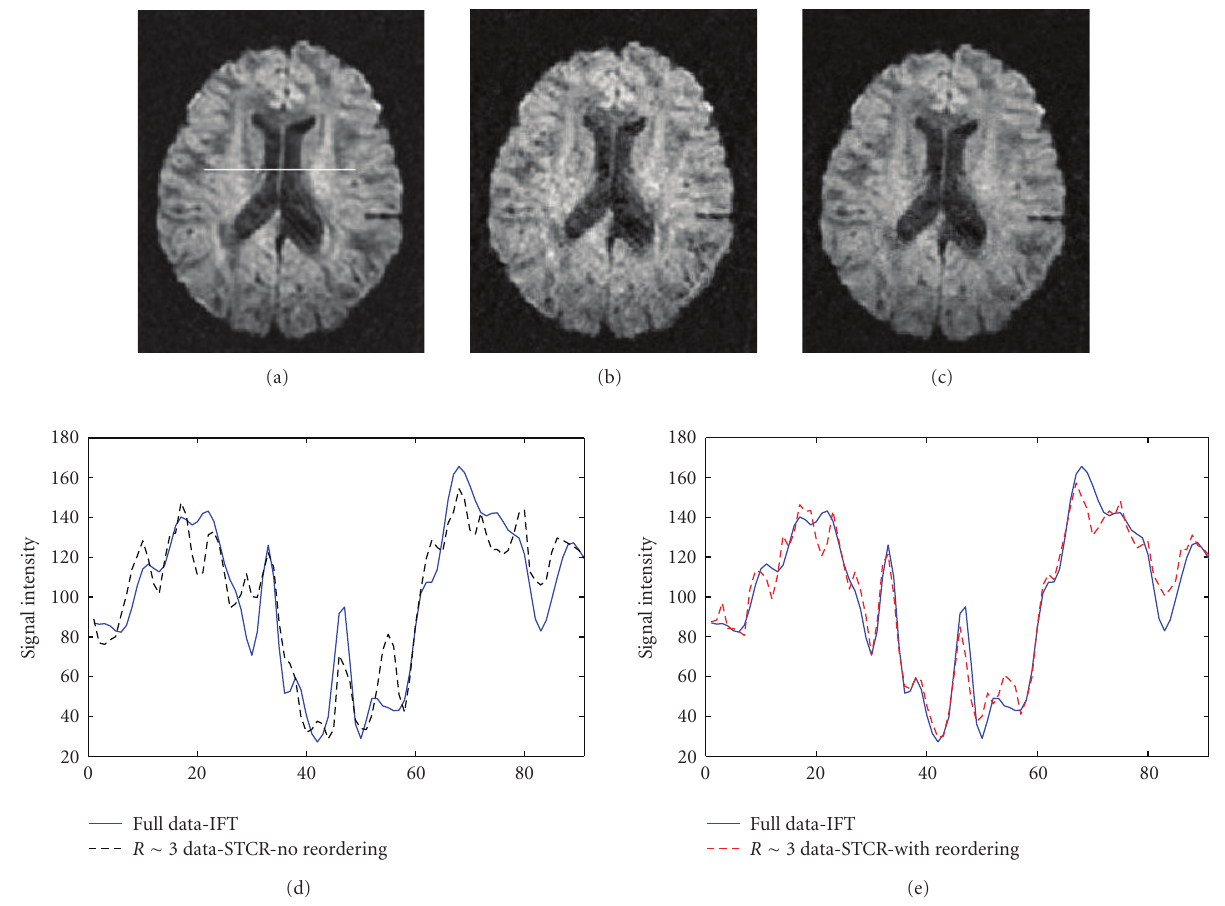
Figure 9: Result of the reordering method on multi-image brain DTI data. (a) Image of a single di ff usion encoding direction reconstructed from full Fourier data. A line for comparison of pixel intensity profiles for di ff erent reconstructions is also shown. (b) Corresponding encoding direction reconstructed from R ∼ 3 Fourier data, undersampled in variable density random fashion, using constrained reconstruction in (4) but without any reordering. (c) Corresponding direction reconstructed from the incomplete Fourier data using constrained reconstruction in (4) with reordering. (d) Comparison of intensity line profiles for images in Figures 9(a) and 9(b). (e) Comparison of intensity line profiles for images in Figures 9(a) and